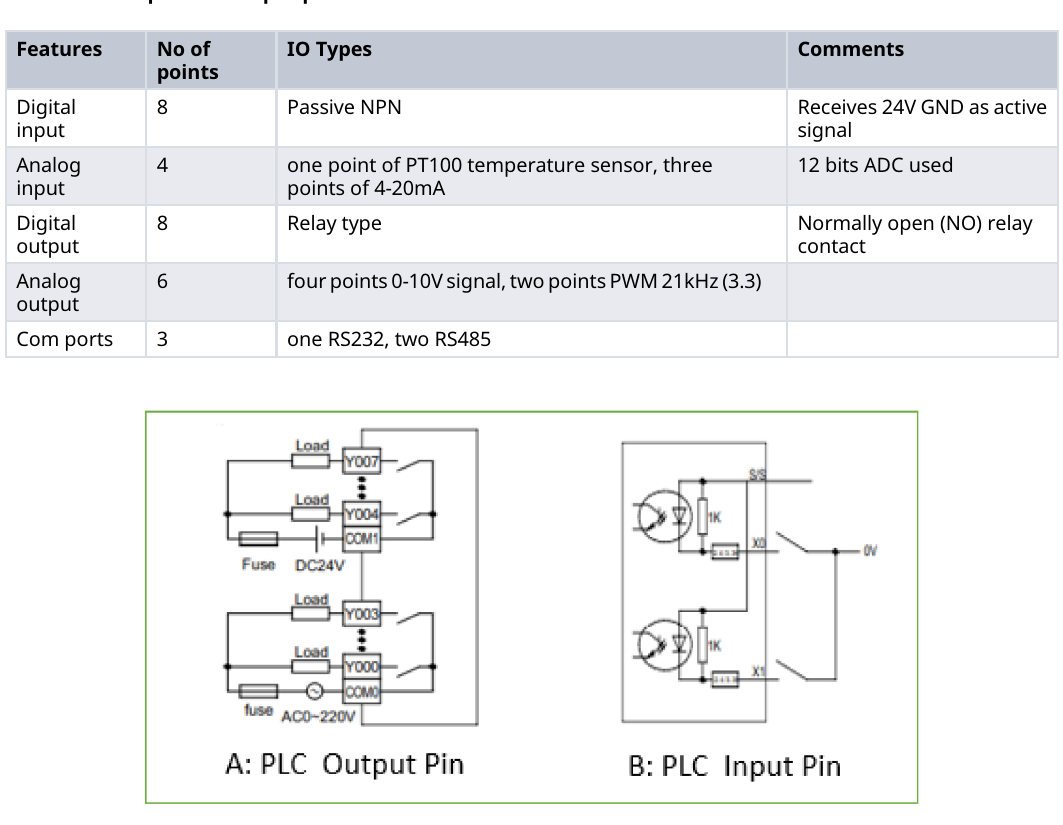
Table 2. PLC input and output ports.